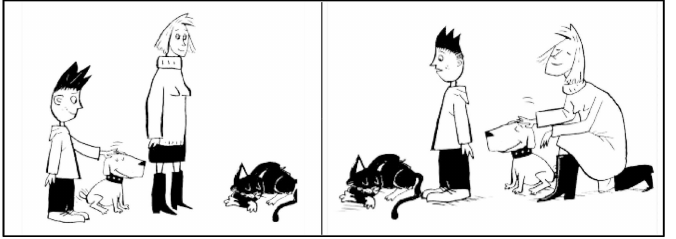
Figure 1. Set of two images associated with a target sentence in the comprehension task. The sentence is: “The boy looks at the cat and the mum cuddles the